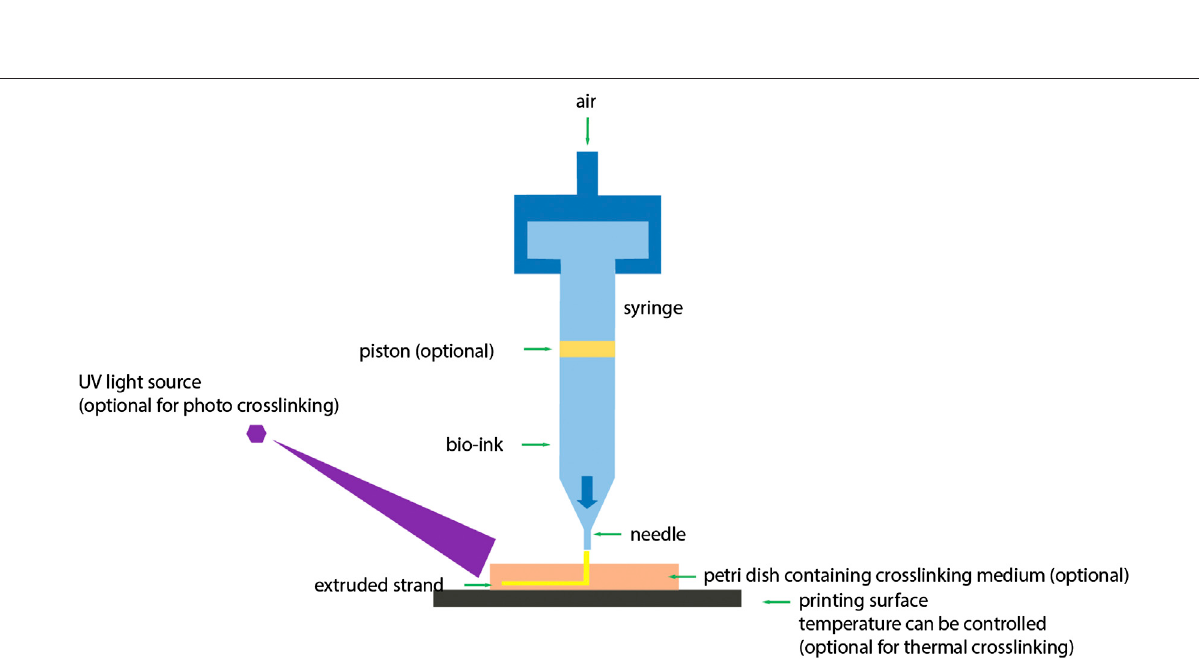
Frontiers in Mechanical Engineering |